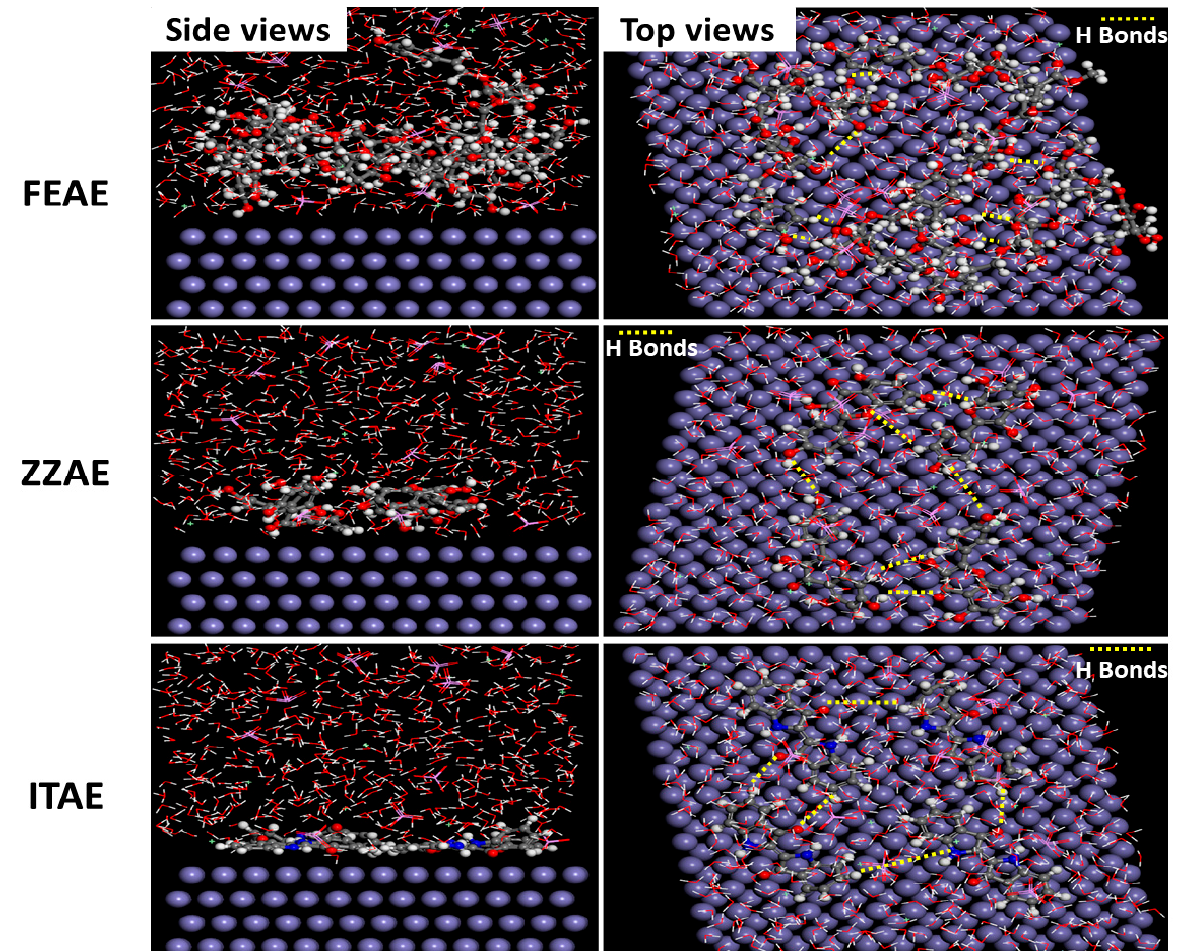
Figure 11. Adsorption process of the plant extracts on Fe(110) in the presence of corrosive species using MD simulations (high symmetry configurations for 4 inhibitor compounds).